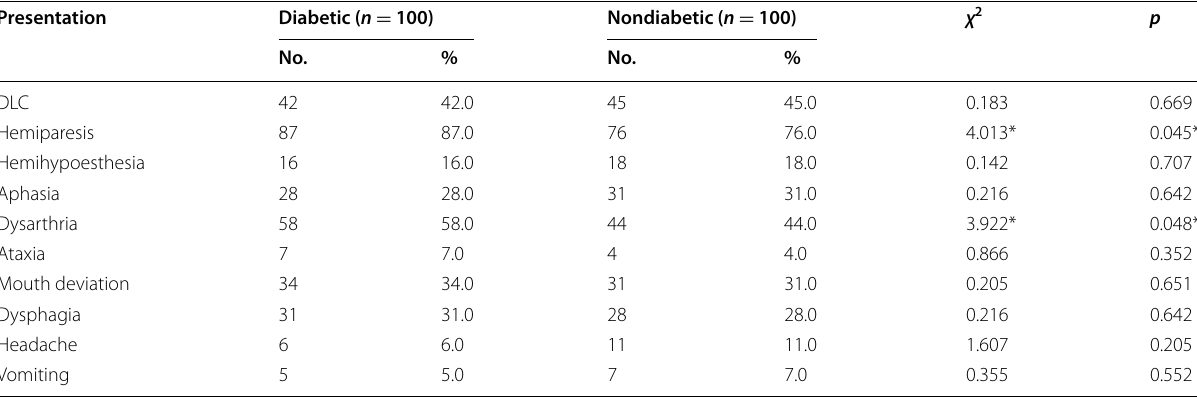
Table 4 Comparison between the two studied groups according to presentation